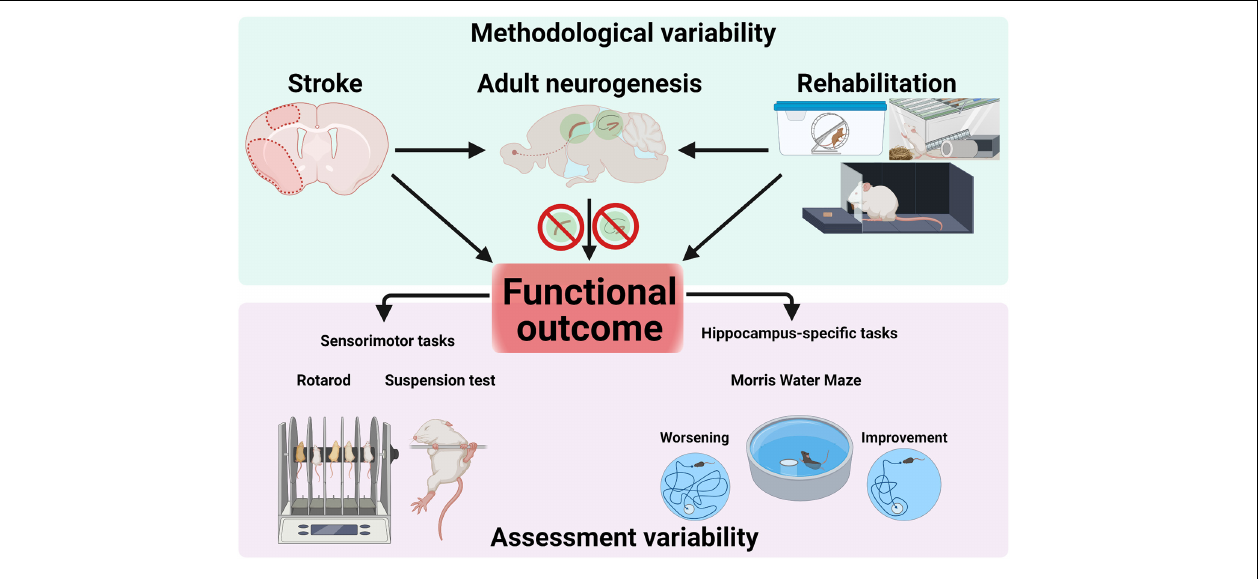
FIGURE 3 | Sources of variability in research on adult neurogenesis after stroke. Methodological factors (e.g., stroke protocol, size and location), rehabilitative interventions (e.g., running, enriched environment or forced reaching training) as well as pharmacological/genetical manipulations blocking adult neurogenesis converge and interact to influence functional outcome. Assessment of functional outcomes assumes using appropriate, specific tests to probe sensorimotor or cognitive performance. Confounding results can occur through the use of unspecific tests (e.g., not probing hippocampus-dependent